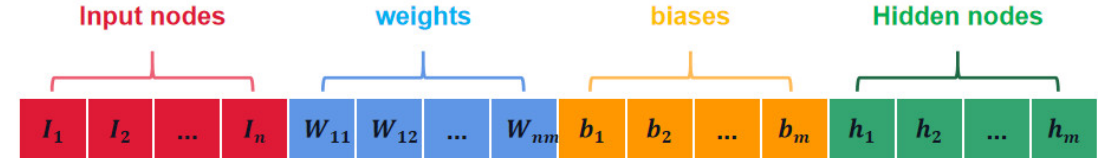
Figure 2. Search agent structure diagram.